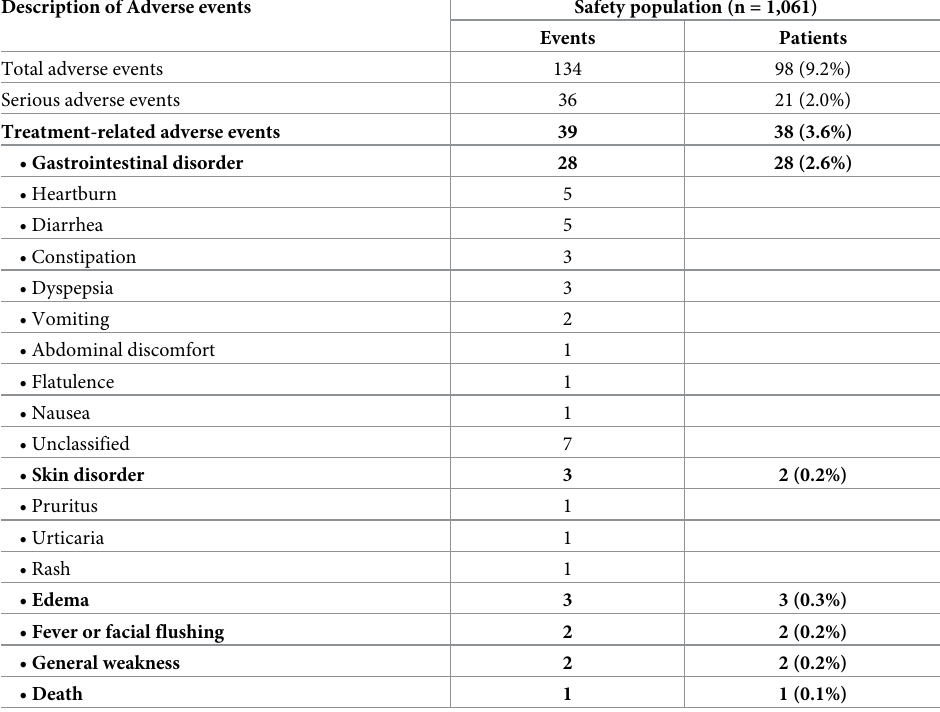
Table 4. Adverse events during the study